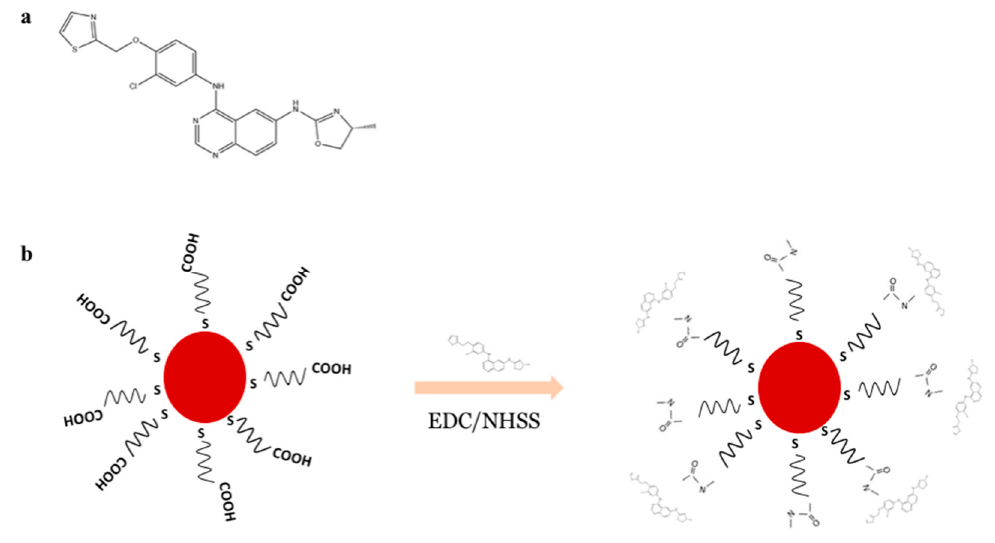
Figure 2. ( a ) Chemical structure of varlitinib; ( b ) Scheme of nanoconjugate PEGAuNPsVarl